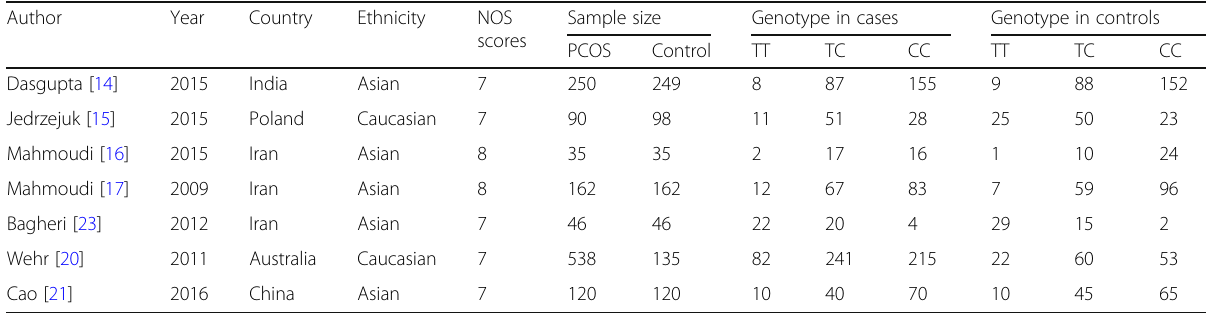
Table 4 Characteristics of studies on VDR FokI rs2228570 (C > T) variant and polycystic ovarian syndrome (PCOS)